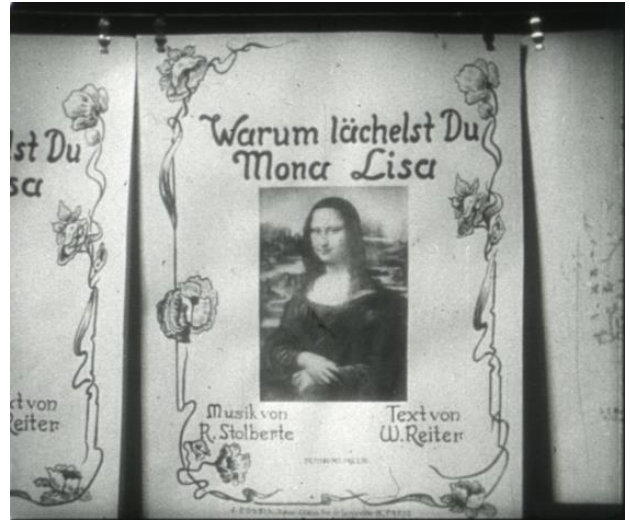
Figure 1. The insert shows the composition “Warum lächelst du Mona Lisa” with “Music by R. Stolberte / Lyrics by W. Reiter” (film still, Filmarchiv